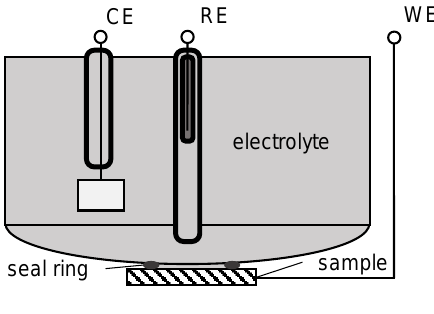
Figure 3. Schematic representation of the used cell arrangement.